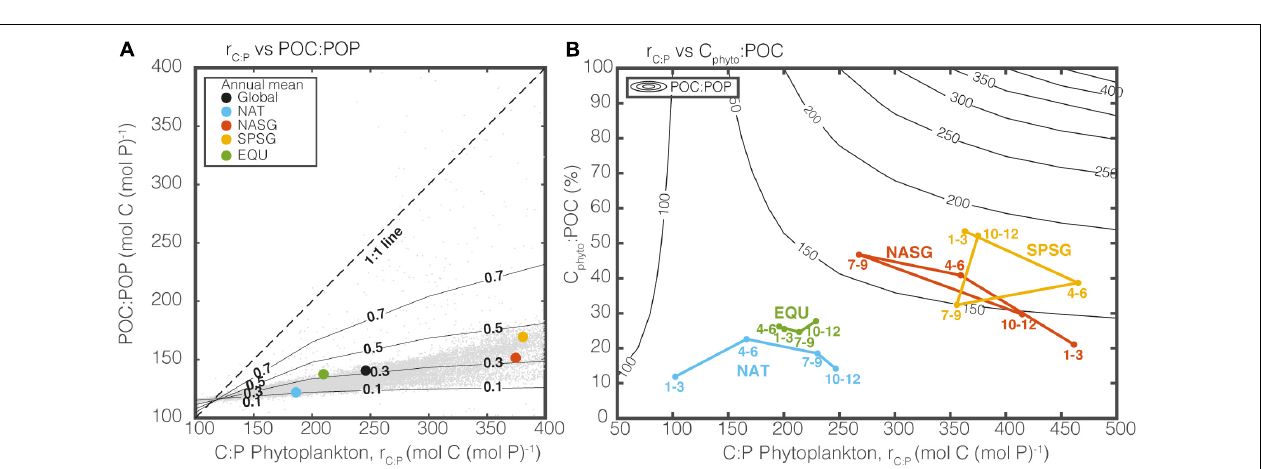
FIGURE 6 | Two graphical representation of the influence of r C : P and C phyto :POC on bulk POC:POP. In Panel (A) , r C : P is plotted against POC:POP and contour lines show C phyto :POC from 0 to 1. The colored dots are annual mean CAFE-informed r C : P and POC:POP from the selected regions, and the gray dots in the background are monthly predictions from each 1 ◦ by 1 ◦ grid point. In Panel (B) , r C : P is plotted against C phyto :POC and the contour lines show POC:POP. Colored points represent seasonally averaged POC:POP for four oceanographic regions, as in Figure 2 . Both Panels (A,B) highlight the importance of top-down control on POC:POP by C phyto :POC.